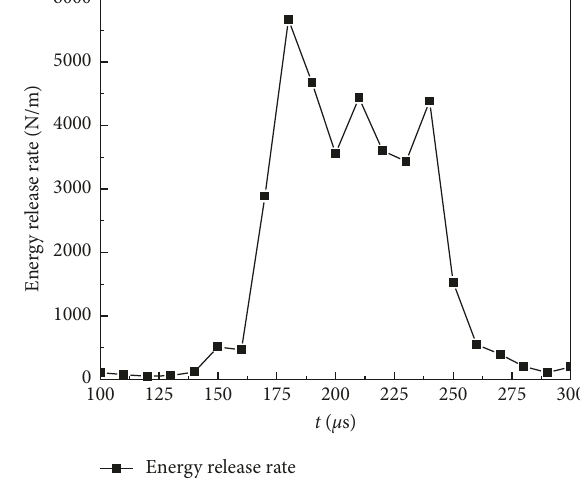
Figure 7: Arc wave velocity curve. Figure 8: Energy release